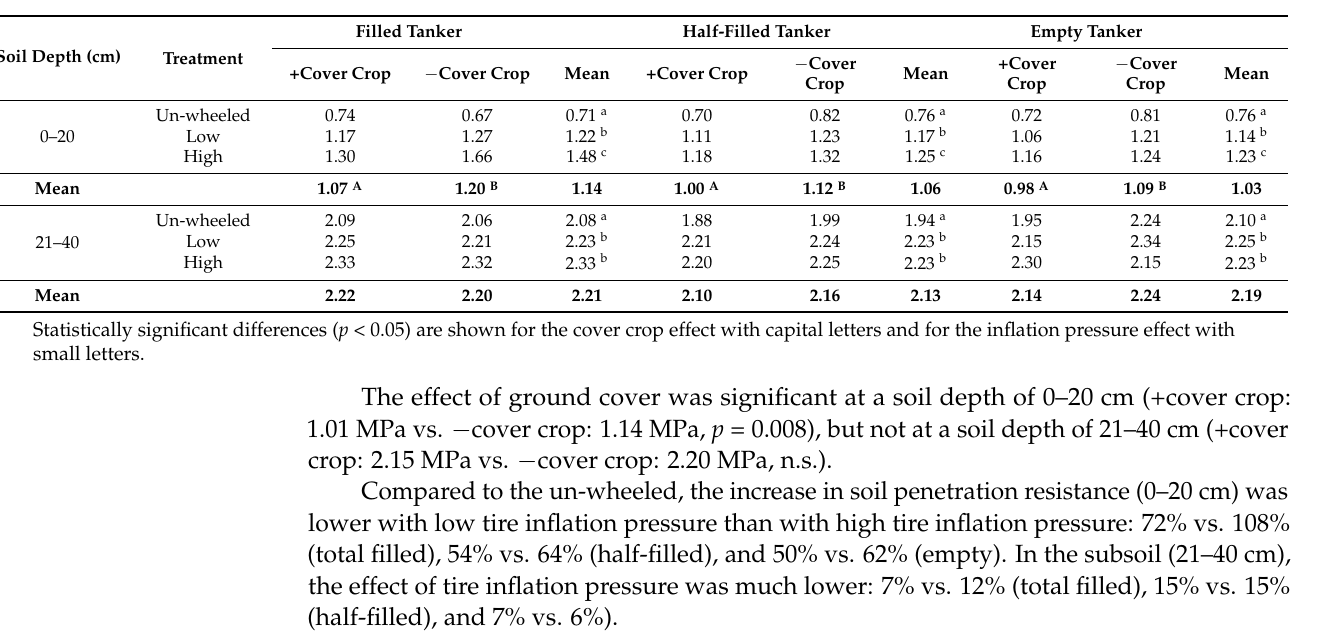
Table 4. Soil penetration resistance (MPa), averaged for the depths (0–20 cm and 21–41 cm) affected by the treatment (un-wheeled, low and high inflation pressure), filling level of slurry tanker (filled, half-filled, empty), and ground covering (+cover crop, − cover crop).